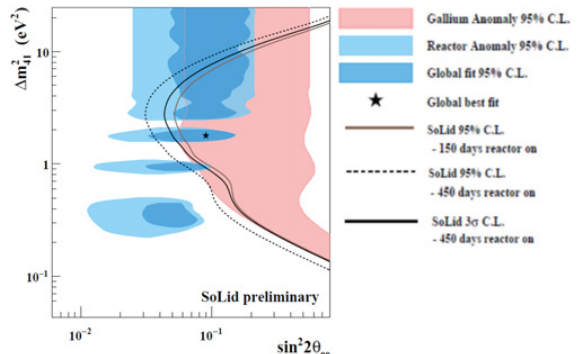
Figure 3. Number of detected IBD events as function of visible Figure 1. 95% CL regions of gallium and reactor annomalies are energy, E v is , and traveled distance, L , in case of oscillations with indicated in the sin 2 (2 θ ee ) − (cid:2) m 2 parameter space. Envisaged 41 contourplot of the SoLid experiment is shown, assuming 30% IBD efficiency, 14% energy resolution and S:B of 3.